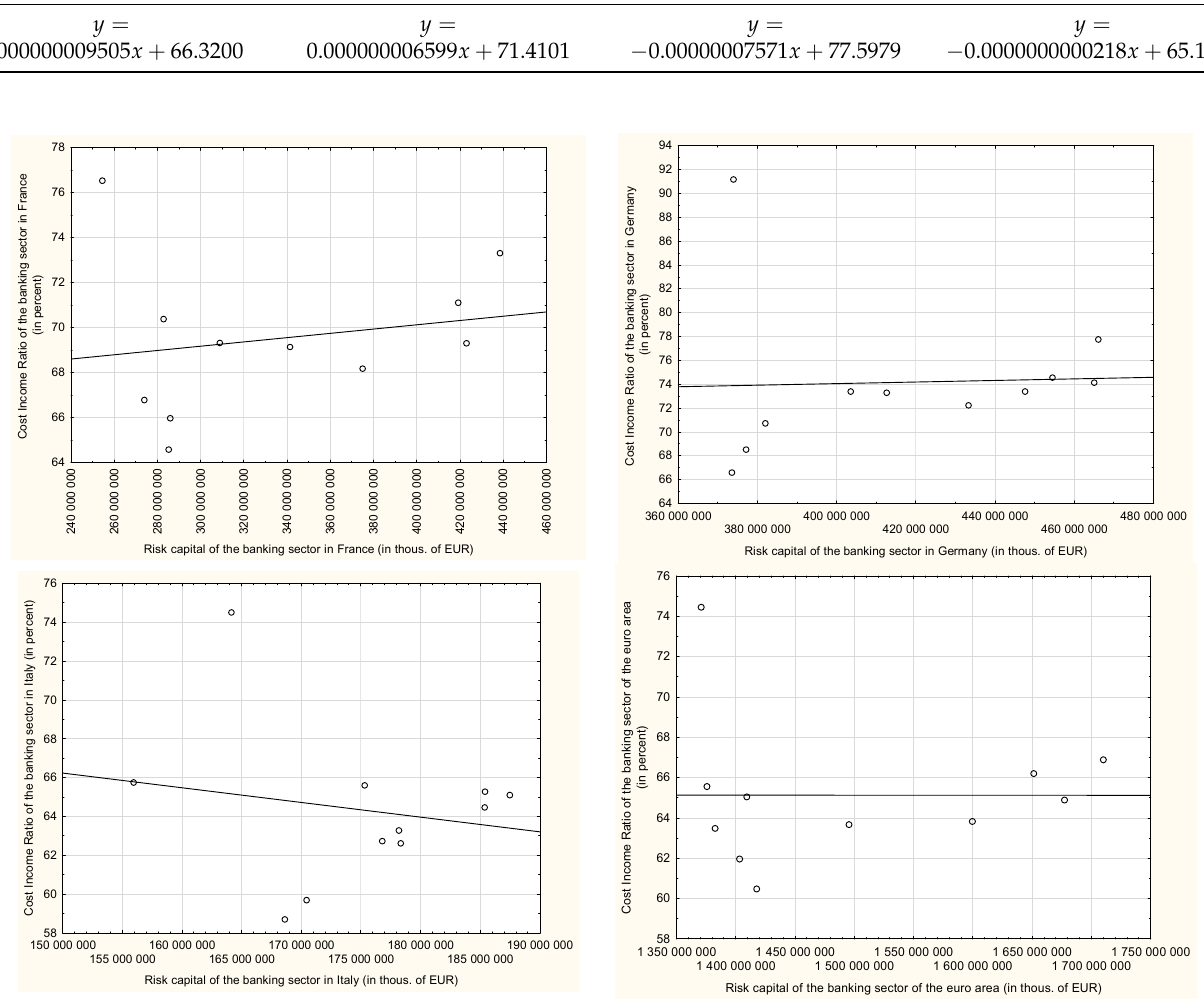
Table 3. Regression models of stage 3 (source: own work).